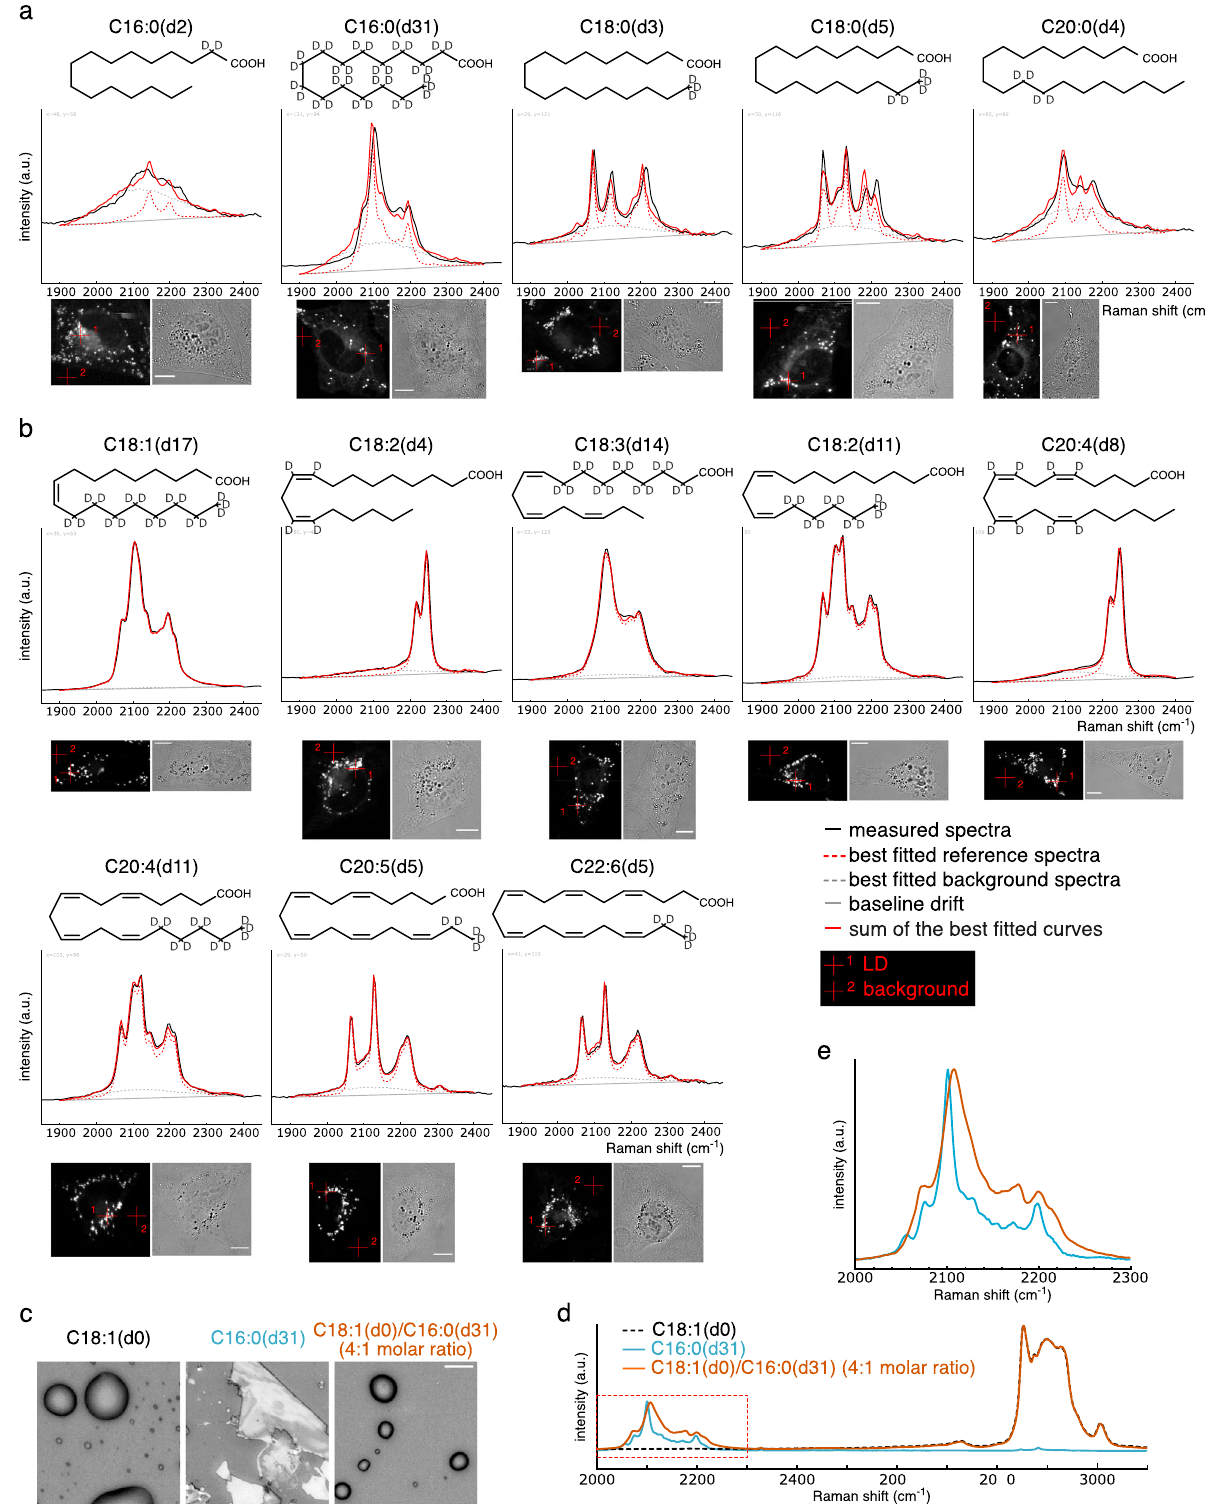
physical state of lipids, that is, solid and liquid states, but also represented continuous physical properties of lipids. For this purpose, we chose C16:0(d31), which displayed the clearest differences between in vitro and in vivo spectra, with the latter exhibiting a wider maximum peak around 2100 cm − 1 and a slight right shift of the peak top. While the pure C16:0(d31) in vitro was COMMUNICATIONS BIOLOGY| (2021) 4:1176